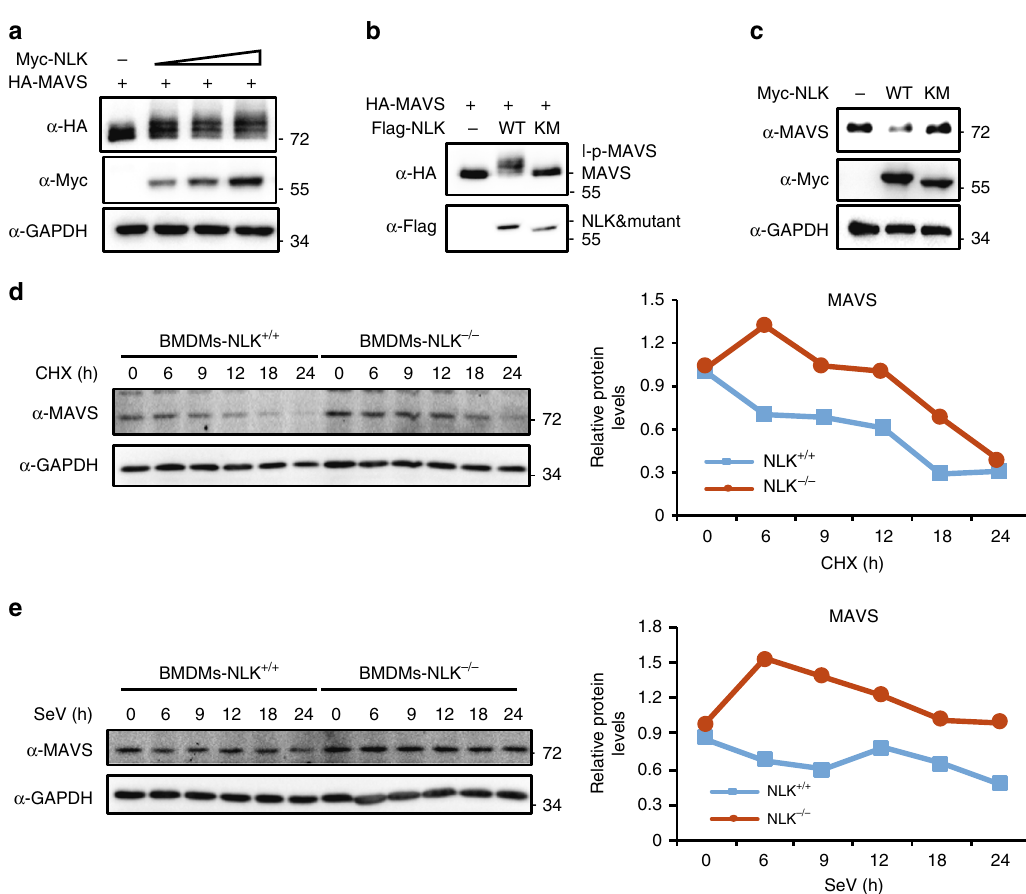
Fig. 6 NLK mediates the degradation of MAVS. a NLK-induced dose-dependent degradation of MAVS. HEK293T cells were transfected with HA-MAVS and increasing amounts of Myc-NLK. The protein levels of MAVS and NLK were determined after transfection for 12 h through immunoblotting using the HA and Myc antibodies. b , c NLK and NLK KM were analyzed for MAVS degradation. b HEK293T cells were transfected with HA-MAVS and Flag-NLK or Flag-NLK KM . The protein levels of MAVS and NLK were determined via immunoblot analysis using HA and Flag antibodies. c HEK293T cells were transfected with Myc-NLK or Myc-NLK KM . The protein levels of MAVS and NLK were determined through immunoblot analysis using MAVS and Myc antibodies. d Stability of MAVS in wild-type and NLK-de fi cient BMDMs. BMDMs were treated with CHX for the indicated periods, and the cell lysate was then subjected to immunoblot analysis using the MAVS antibody. Relative levels of MAVS were calculated after normalization to GAPDH and are shown in the right panel. e Stability of MAVS in wild-type and NLK-de fi cient BMDMs after SeV infection. The BMDMs were treated with CHX for the indicated periods, and the cell lysate was then subjected to immunoblot analysis using MAVS antibodies. The relative levels of MAVS were calculated after normalization to GAPDH and are shown in the right panel. Data are representative of three independent experiments. Source data ( a – e ) are provided as a Source Data fi